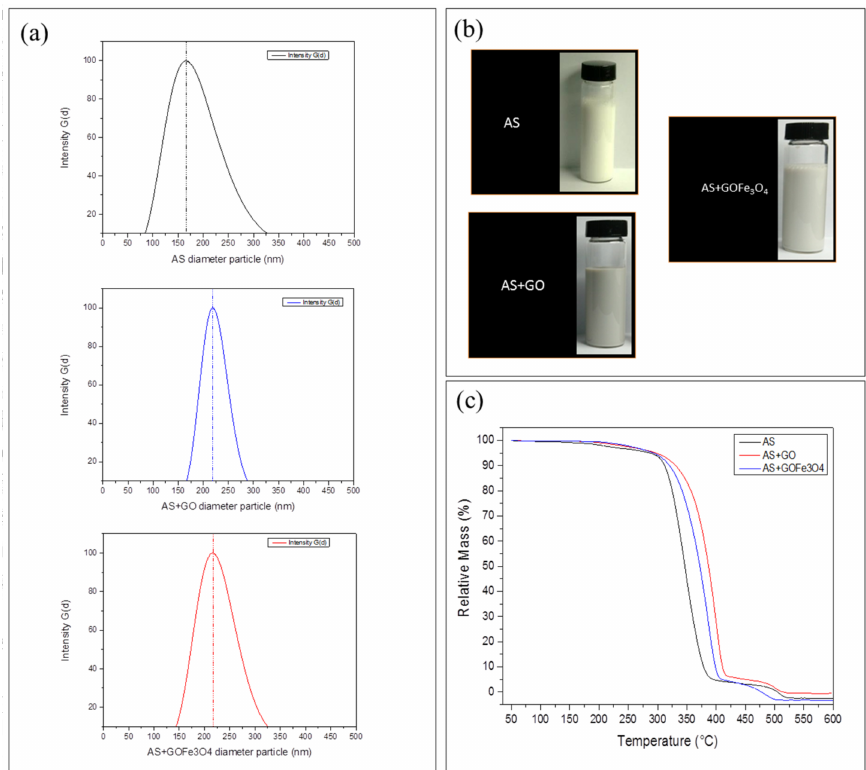
Figure 6. Results showing the properties of the emulsion and dried films coating the fibers with ( a ) the effect of the ferrites on the particle diameter size in emulsion and ( b ) photos of sizing formulations and ( c ) thermal stability of the sizing films with different